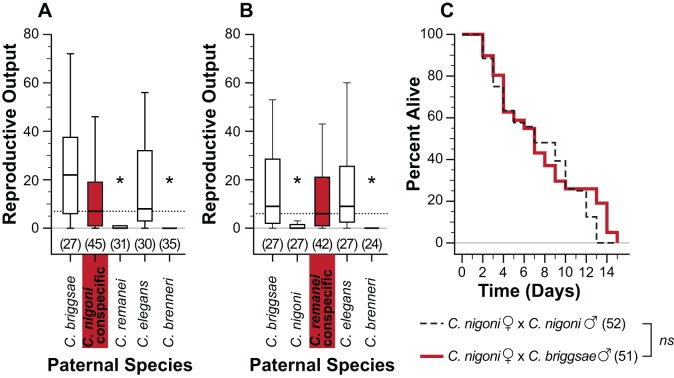
Impacts of inter-species matings on females.Females from dioecious species (A: C. nigoni, B: C. remanei) were initially mated overnight to conspecific males, followed by overnight mating of treatment females (white) to heterospecific males from either dioecious (C. nigoni, C. remanei, C. brenneri) or androdioecious (C. briggsae, C. elegans) species; control females (red) did not receive a second mating. Reproductive output was then quantified as the number of progeny produced two days post mating treatment. (A, B) Females often became sterilized upon a subsequent mating with heterospecific males from dioecious species compared to controls: (A) C. nigoni females (C. remanei males U = 385.5, p = 0.001; C. brenneri males U = 206.5, p≤0.001), (B) C. remanei females (C. nigoni males U = 239.5, p≤0.001; C. brenneri males U = 259.5, p≤0.001). However, females were resistant to harm induced by males of androdioecious species: (A) C. nigoni (C. briggsae males U = 409.5, p = 0.020; C. elegans males U = 577.0, p = 0.291), (B) C. remanei (C. briggsae males U = 887.0, p = 0.886; C. elegans males U = 863.0, p = 0.731). (C) C. nigoni females mated to heterospecific C. briggsae males (solid red line) did not incur a statistically significant survival cost relative to conspecific mating (dashed black line; Kaplan-Meier log-rank test: χ2 = 0.203, df = 1, p = 0.652; ns not significant). Asterisks in (A and B) indicate significant difference from controls (Bonferroni correction for multiple tests were applied; corrected α = 0.0125). Boxplot whiskers in (A and B) indicate 1.5× (interquartile range) and dotted horizontal lines indicate median of viable progeny produced by the controls (females mated with conspecifics); sample sizes are shown in parentheses.